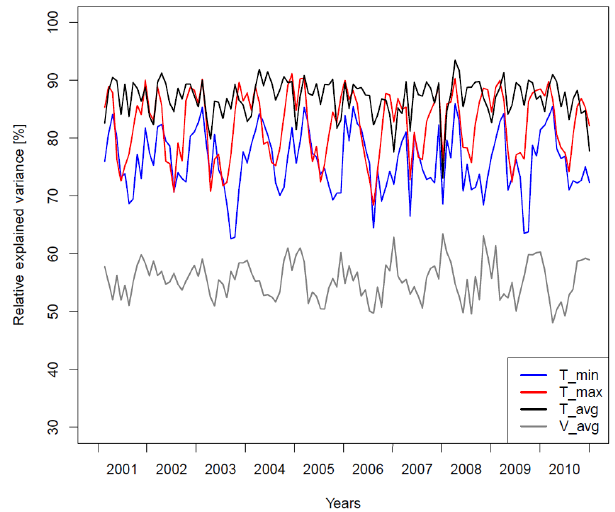
Figure 14. Relative explained variance for monthly mean wind speed and for the monthly mean of the three temperature param- eters (see color code) for